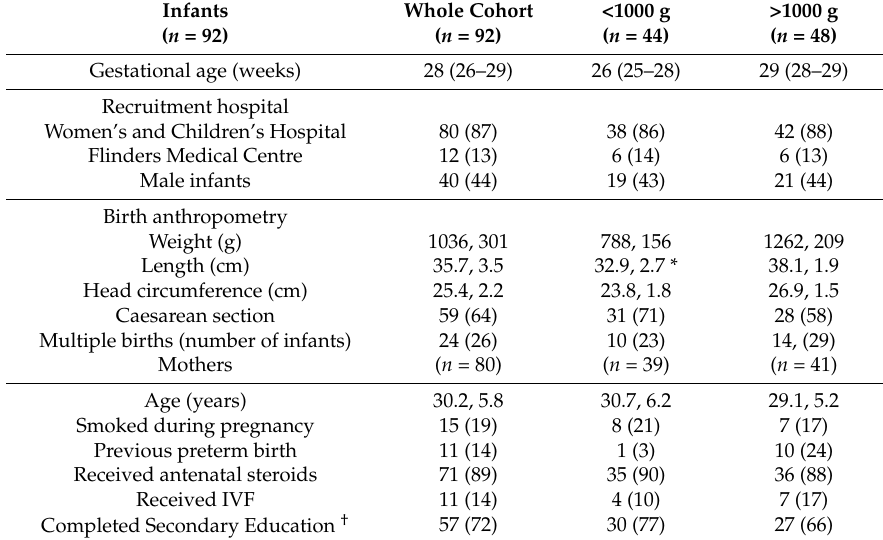
Table 1. Clinical characteristics of